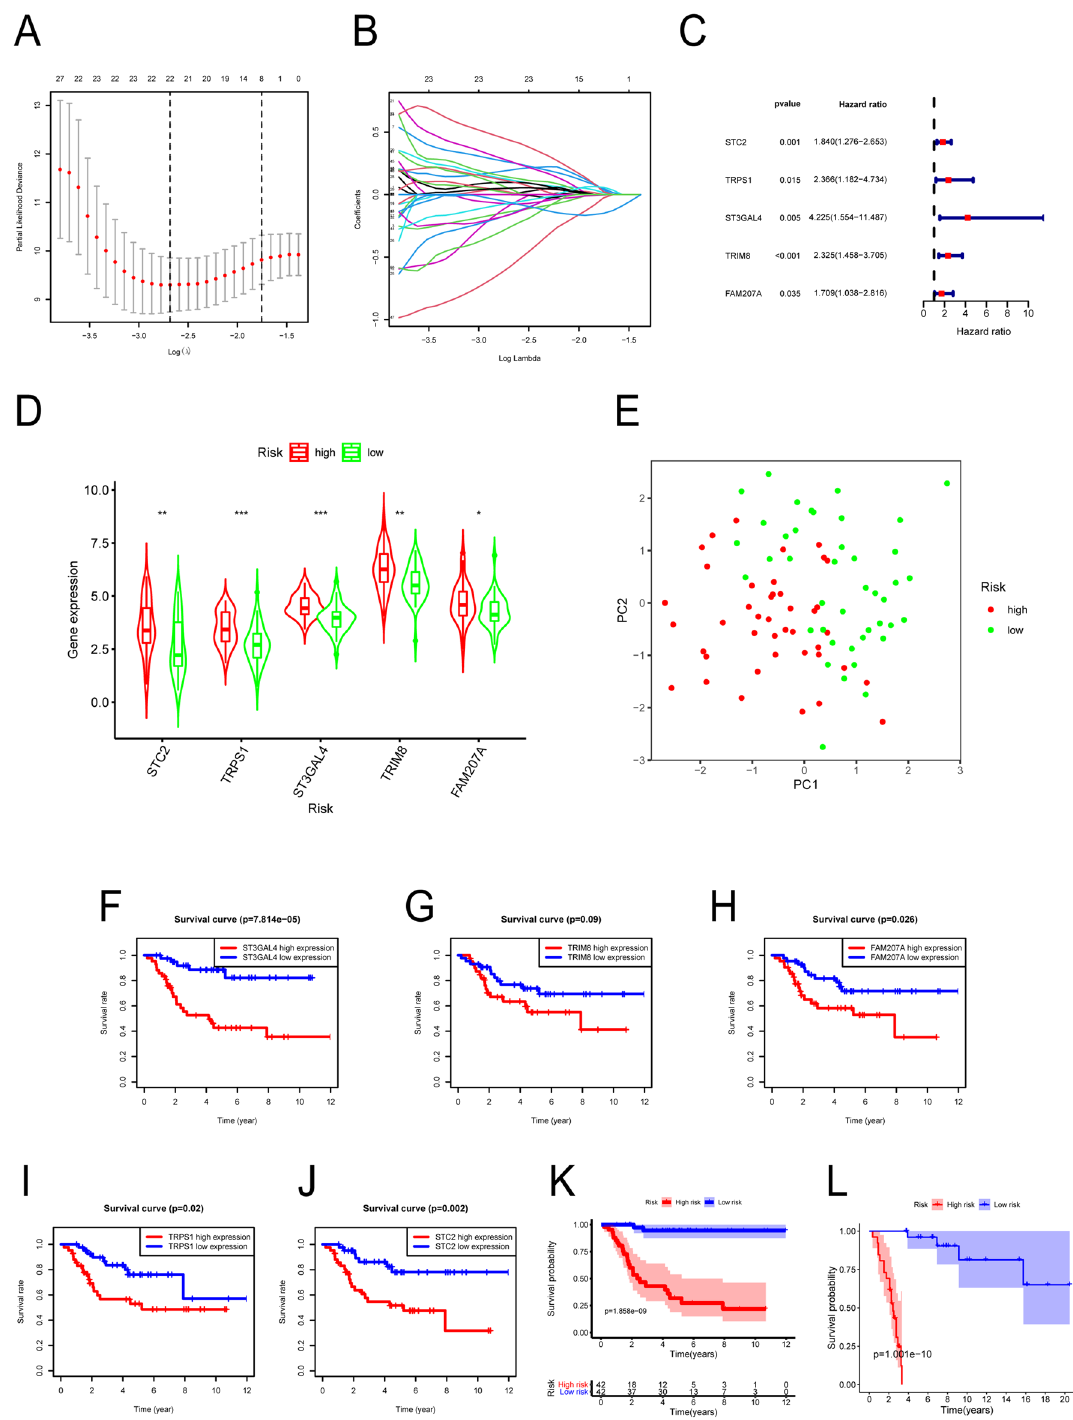
Figure 2. Construction of a prognostic model for osteosarcoma and the survival analysis of the screened genes. ( A ) Ten-fold cross-validation of Lasso regression model adjustment parameter selection (nfold = 10). ( B ) The Lasso coefficient curve of the 22 genes that were included in the analysis. ( C ) The forest plot shows that the multivariate Cox regression analysis of STC2, TRPS1, ST3GAL4, TRIM8, and FAM207A is statistically significant (P < 0.05). ( D ) The violin plot shows the expression difference of the five genes in the high-risk group and the low-risk group. ( E ) The main component analysis chart; the red dots are high-risk patients and the blue dots are low-risk patients. ( F – J ) The survival curves were plotted based on the high and low expression of ST3GAL4, TRIM8, FAM207A, TRPS1, and STC2 genes, respectively. ( K ) A survival curve was plotted based on the high and low risks of the genes used to construct the model. ( L ) A survival curve was plotted in the validation dataset based on high and low risk for the genes used to construct the